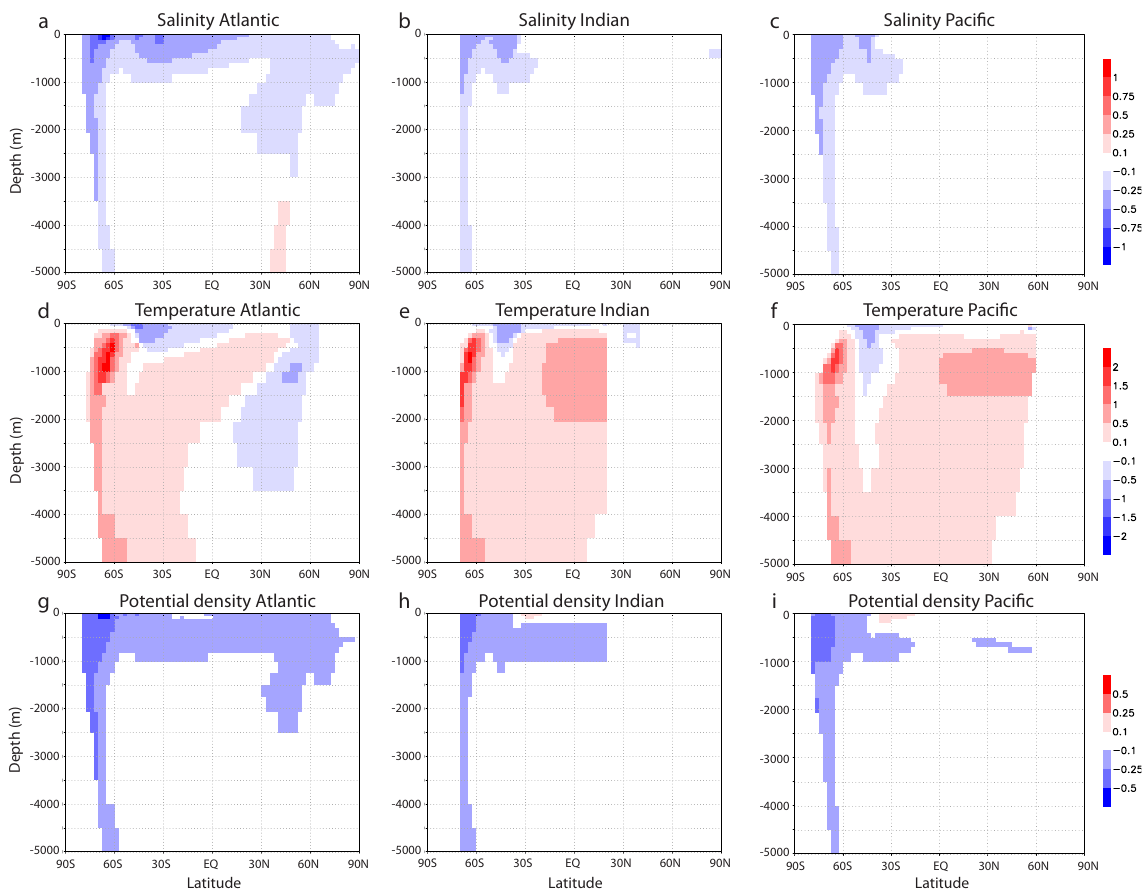
Fig. 16. Zonally averaged salinity (‰), temperature ( ◦ C) and density (kgm − 3 ) anomalies for the simulation during the Preindustrial with a fresh water flux added into the southern part of the Atlantic of 0.5Sv during 400 yr: (a, b, c) salinity; (d, e, f) temperature; (g, h, i) density. The anomalies refer to the difference between the collapse state of the AMOC compared to the control state (years1390–1400 minus years990–1000). The three basins are: (a, d, g) Atlantic, (b, e, h) Indian and (c, f, i)